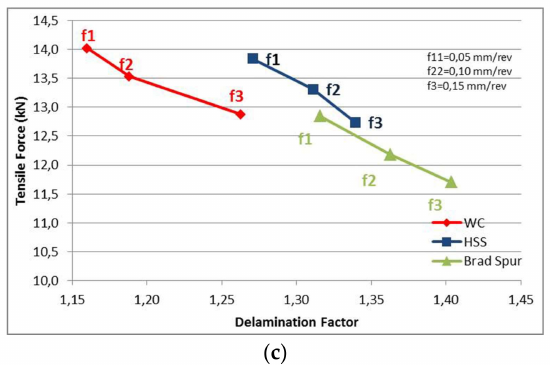
Figure 10. Variation of delamination factor on tensile load: ( a ) 1000 rev/min; ( b ) 3000 rev/min; ( c ) 5000 rev/min.